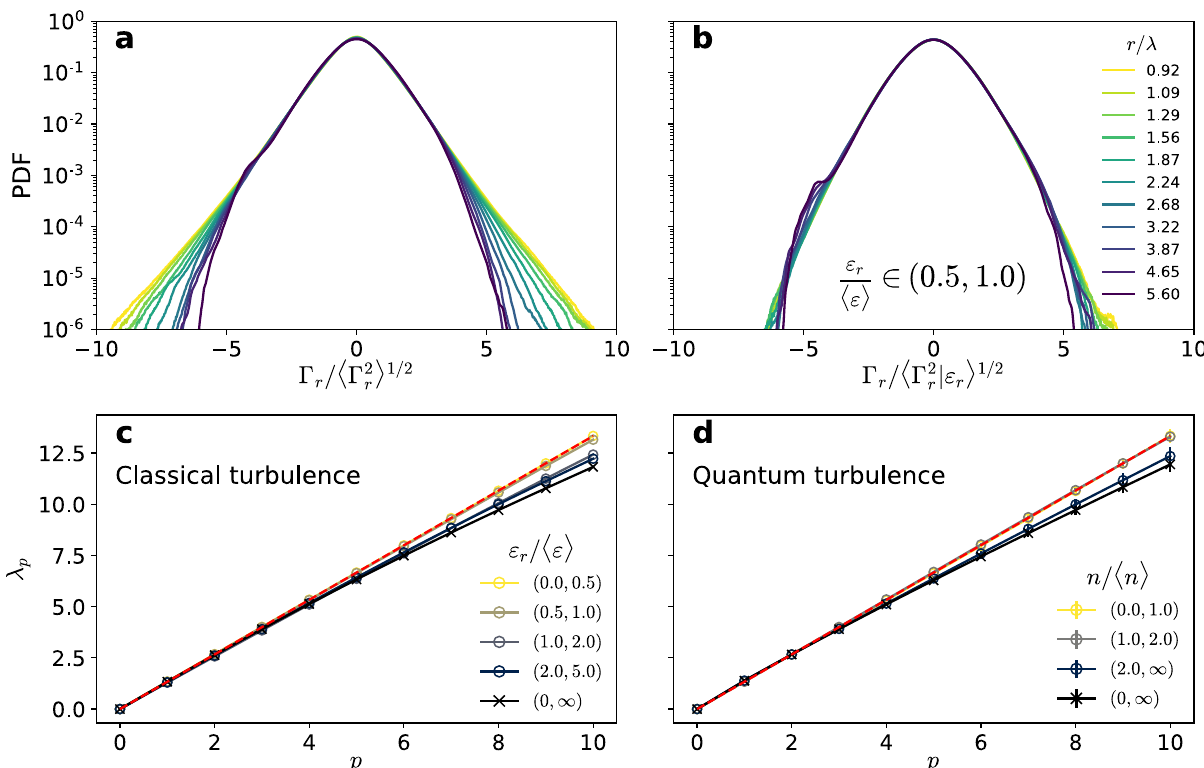
Fig. 6 Circulation intermittency and OK62 theory in classical and quantum turbulence. Top panels: PDFs of the circulation in classical turbulence as a function of the loop size r . a Unconditioned PDFs. b PDFs conditioned on low values of the local coarse-grained dissipation, ε r / 〈 ε 〉 ∈ [0.5, 1]. The different colours correspond to different loop sizes within the inertial range. c , d Scaling exponents of the circulation moments in ( c ) classical and ( d ) quantum turbulence. Different colours indicate a conditioning ( c ) on the local dissipation and ( d ) on the number of vortices within each loop. The unconditioned exponents are shown with black crosses. The Kolmogorov self-similar scaling is shown as reference (red dashed line). Error bars indicate 95% con fi dence